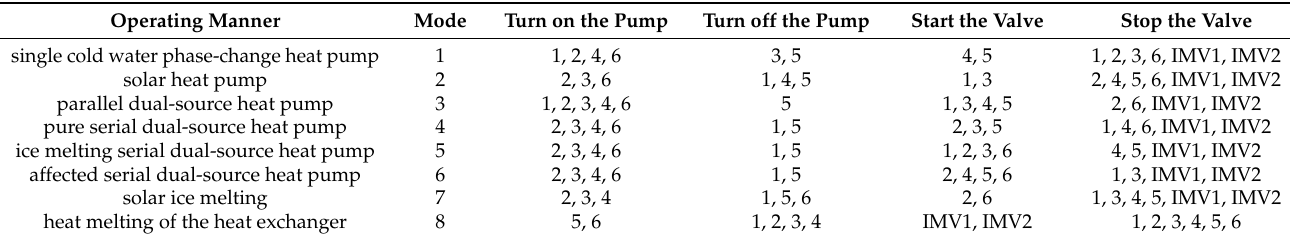
Table 1. SAPCHPs operating modes.